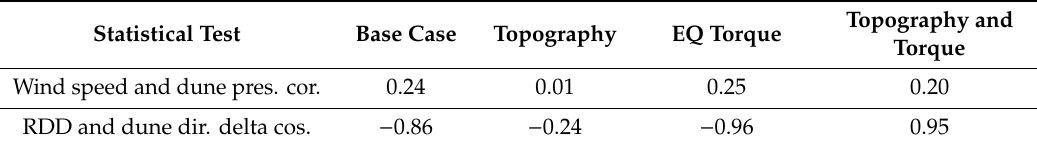
Table 1. Statistical tests comparing our simulated model parameters with dune presence and orientation for a threshold speed of 0 m / s.